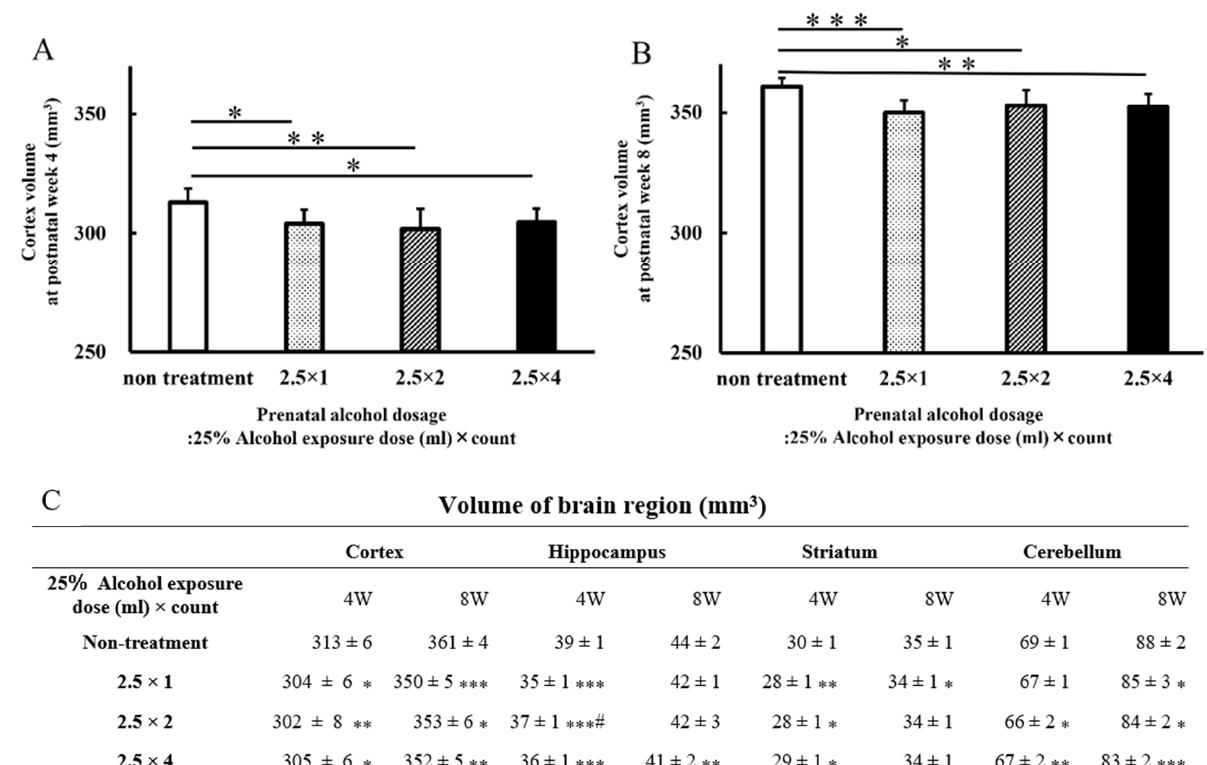
Figure 3. Graphs of postnatal cerebral volume at 4 weeks ( A ) and 8 weeks ( B ). Brain volumes for each brain area at 4 and 8 weeks postnatally: cortex, hippocampus, striatum, and cerebellum ( C ). In the FASD group that received alcohol, there was a larger decrease in brain volume in each brain region compared with that of the non-treated group. Brain volume reduction of the brain regions occurred at 4 and 8 weeks of age. Non-treatment = normal control group (n = 11); 2.5 × 1 = one dose of 2.5 mL of 25% alcohol (n = 11); 2.5 × 2 = two doses of 2.5 mL of 25% alcohol (n = 7); 2.5 × 4 = four doses of 2.5 mL of 25% alcohol (n = 11). Between-group comparisons were analyzed by one-way ANOVA with Tukey’s multiple comparison tests using Prism 9. The results showed no signi fi cant di ff erence between the two-dose group (2.5 × 2) and the four-dose group (2.5 × 4). As compared with the non-treatment group: * p < 0.05; ** p < 0.01; *** p < 0.001. As with the one-dose FASD group (2.5